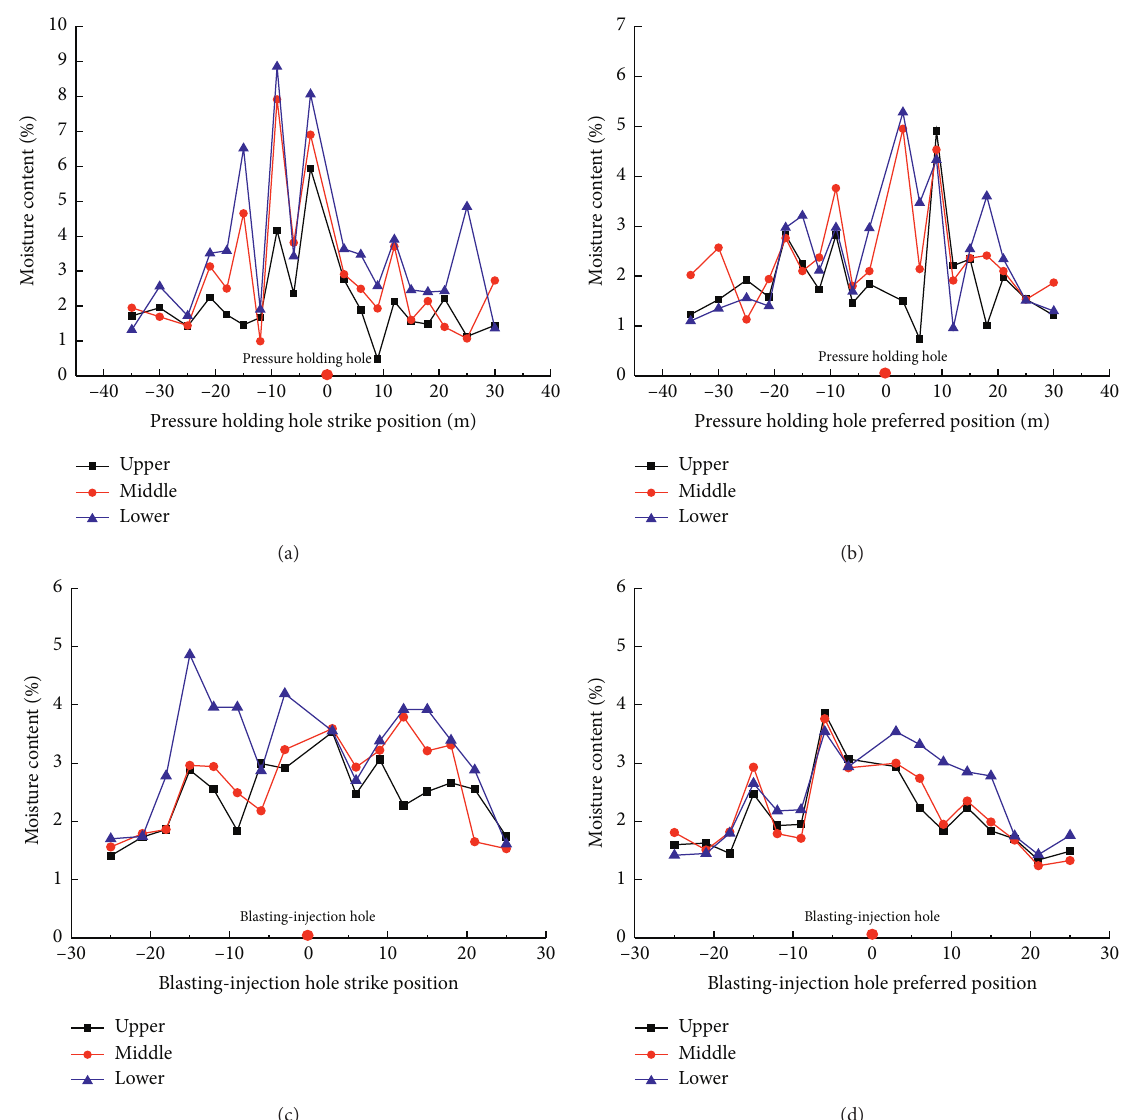
Figure 10: Water cut curve at different positions around the fracturing